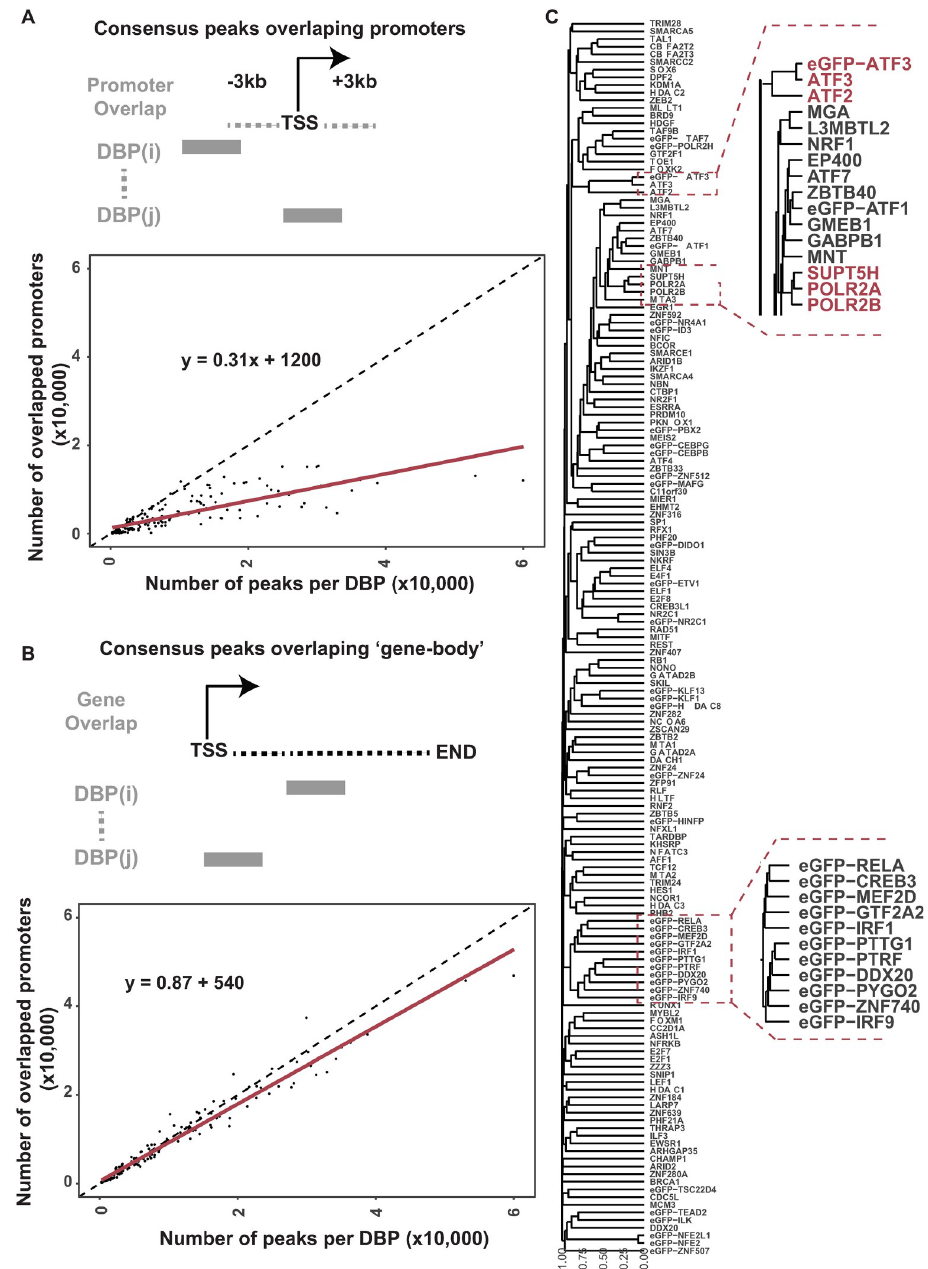
Fig 2. Promoter binding properties of 161 DBPs. (A) Schematic of promoter overlap strategy. Number of overlapping promoters (y-axis) per number of peaks for each DBP (x-axis). (B) Same as in (A) but for overlapping gene bodies instead of promoters. (C) Hierarchical clustering of 161 DBPs based on promoter binding profiles (consensus peaks) with zoom in on specific regions. and randomly placed them across the genome, while controlling for (i) number of peaks, (ii) width of peaks and (iii) number of peaks on each chromosome. We then performed a Fisher exact test of the observed binding at lncRNA and mRNA promoters versus expected binding in the empirically derived null distributions. We observed that nearly all DBPs exhibit